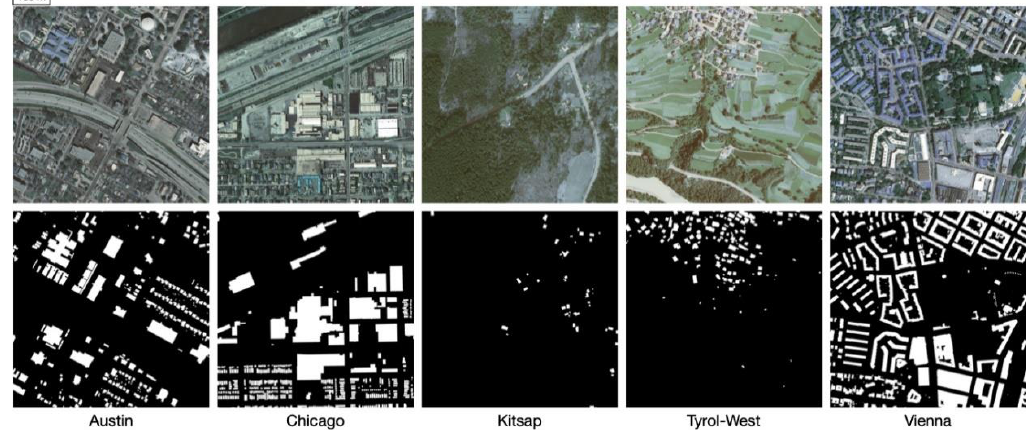
Figure 6. Visual close-ups of the Inria dataset images from five different regions and their corresponding reference data.